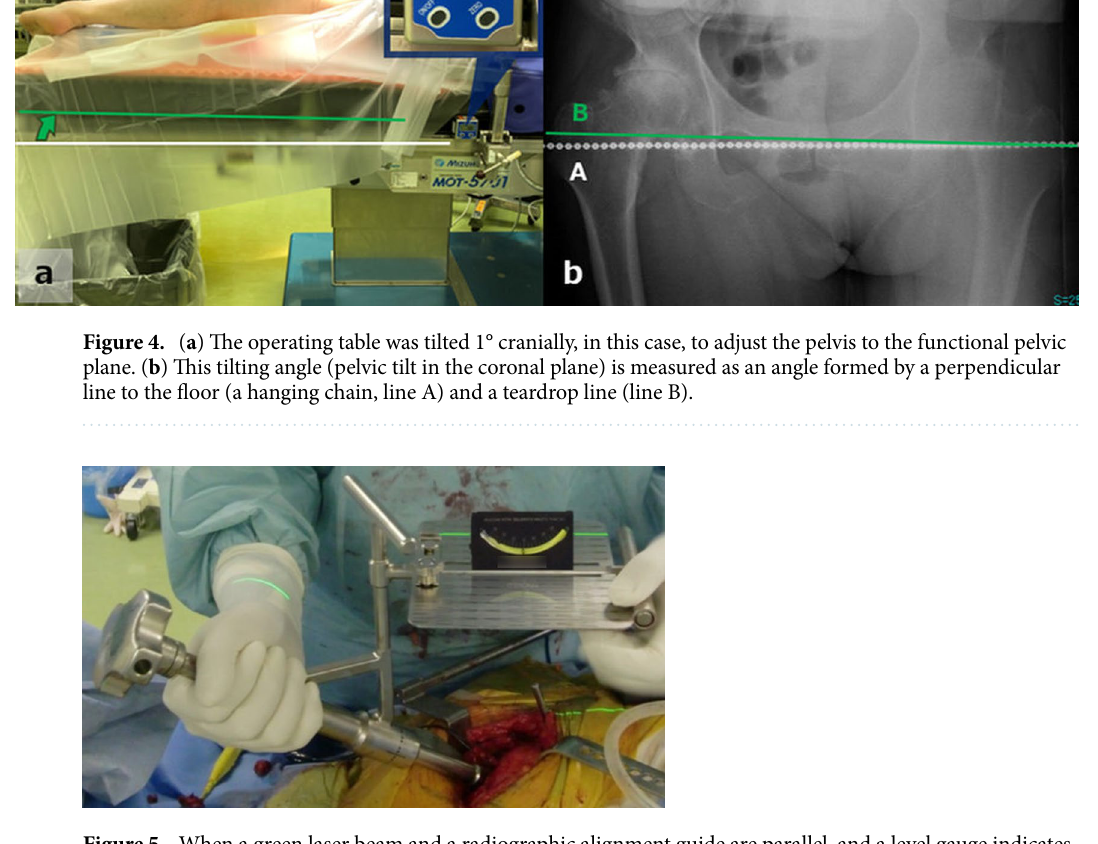
Figure 5. When a green laser beam and a radiographic alignment guide are parallel, and a level gauge indicates 0° in both coronal and axial planes, a cup is supposed to be in 40° of radiographic inclination and 20° of radiographic